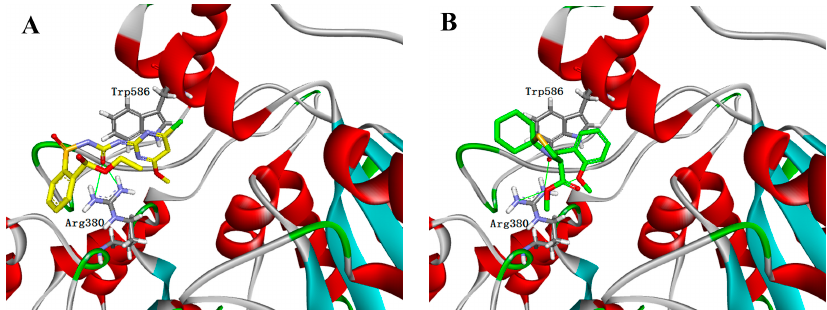
Figure 4. Zoomed-in view of the docking modeling of chlorimuron-ethyl ( A ) and 4e ( B ). The carbon atoms are shown in yellow ( A ) and green ( B ); the sulfur atoms are shown in brown ( A ) and yellow ( B ); the oxygen atoms are shown in red ( A , B ); the nitrogen atoms are shown in blue ( A , B ), and the chlorine atoms are shown in green ( A ).